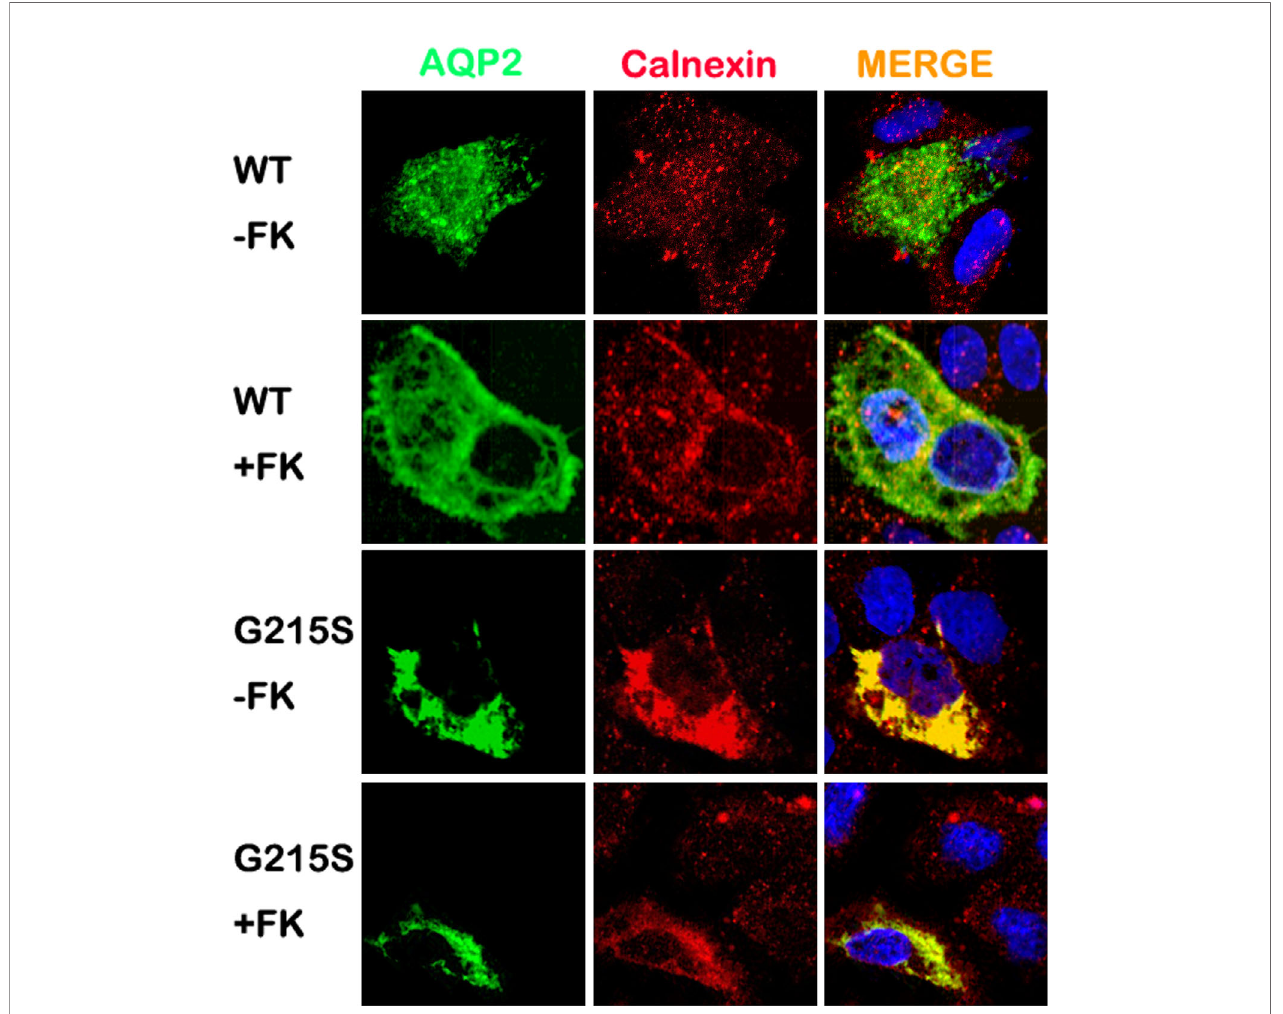
FIGURE 2 | AQP2-G215S was retained in endoplasmic reticulum. MDCK cells were electroporated with AQP2-WT and AQP2-G215S plasmids and stained for AQP2 and endoplasmic reticulum marker (Calnexin). WT, wild type; FK,